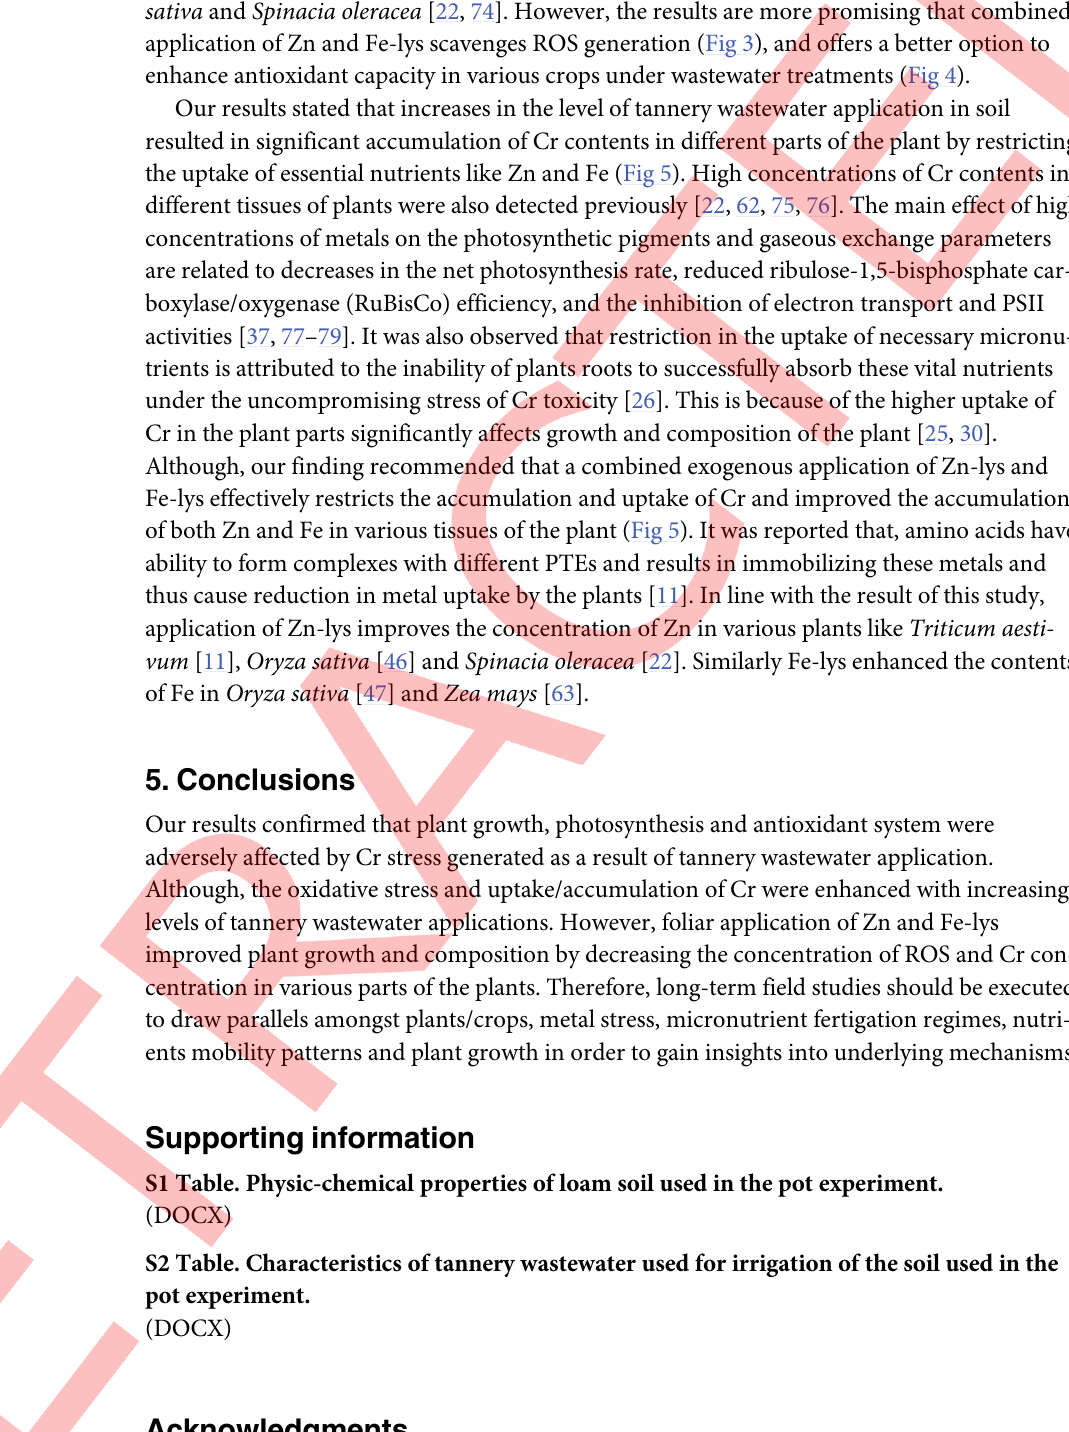
S1 Table. Physic-chemical properties of loam soil used in the pot experiment. S2 Table. Characteristics of tannery wastewater used for irrigation of the soil used in the pot